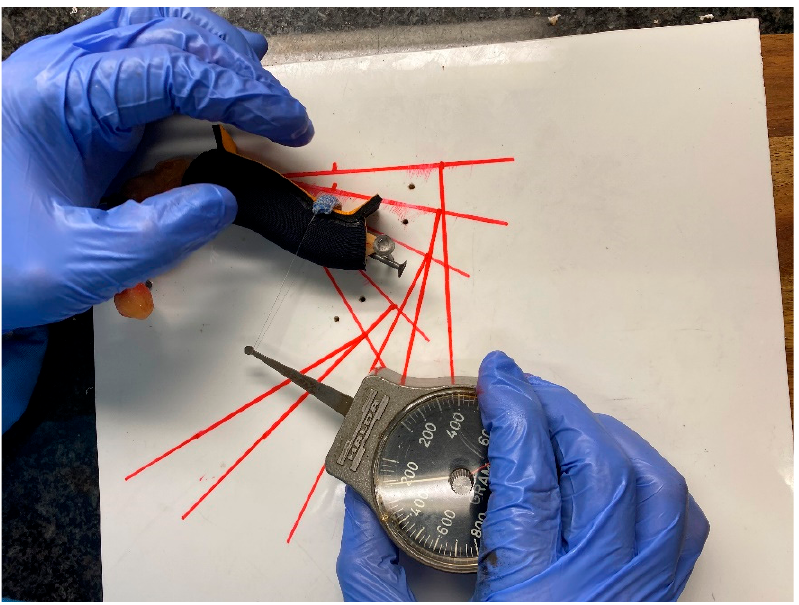
Figure 3. Measurement system of orthoses.